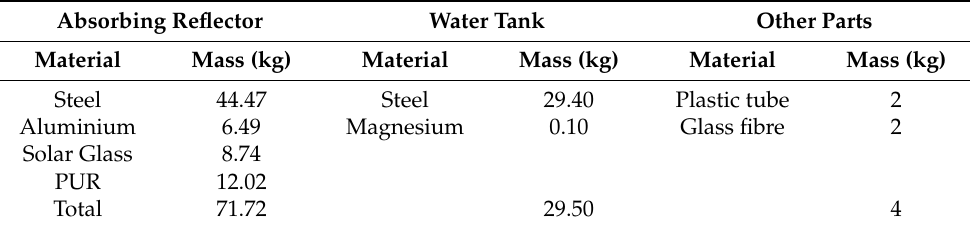
Table 1. Quantified technical details of employed materials for the ICS system.